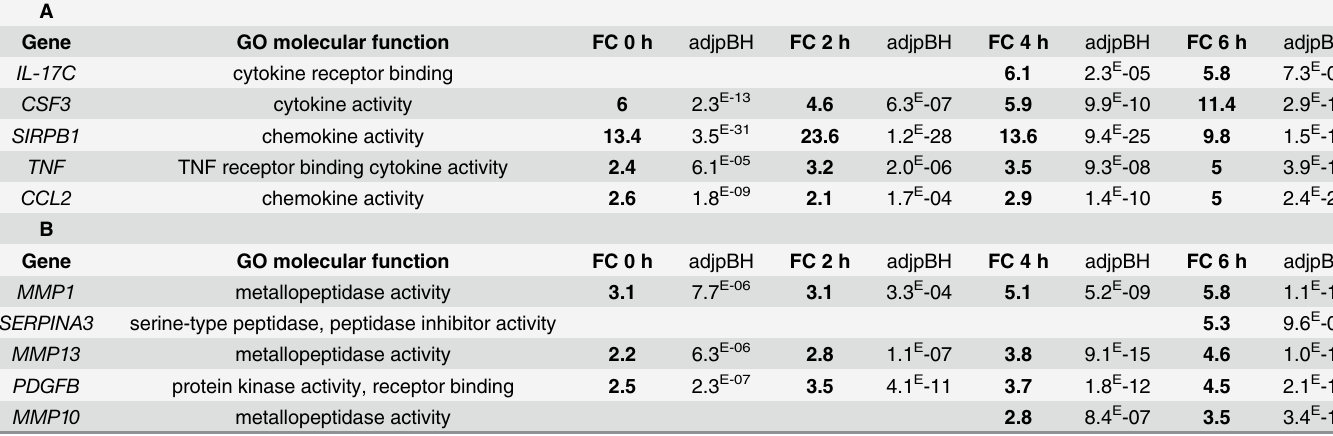
Table 3. Genes in the protein-binding (A) and in the catalytic-activity (B) gene-ontology category: five upregulated with the greatest difference in expression level between cystic-fibrosis and CTRL cells after infection.